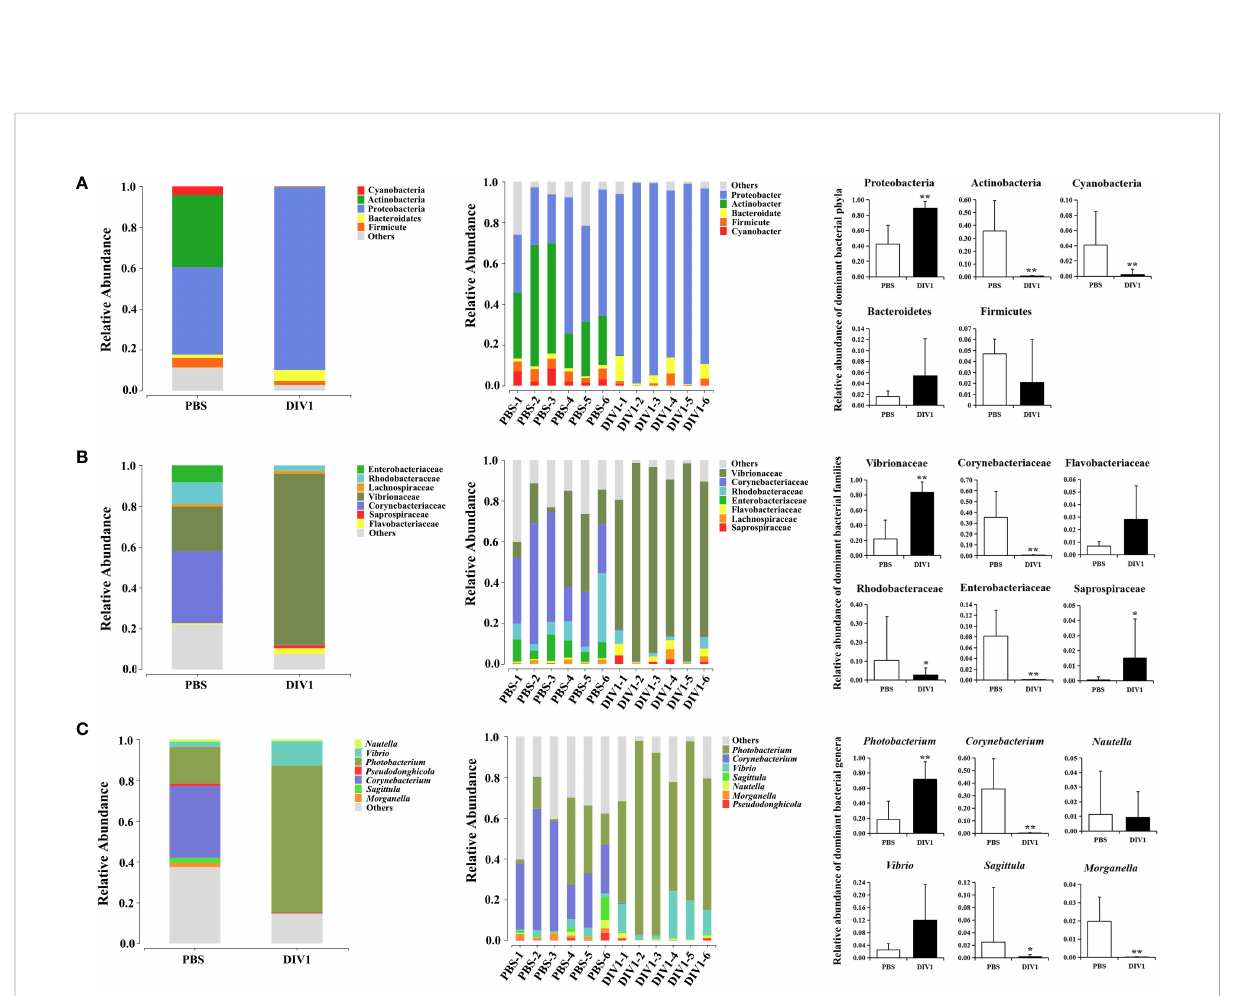
FIGURE 4 Structure and composition of the intestinal bacterial communities under DIV1 infection (mean ± SD). (A) Relative abundances of dominant bacterial phyla. (B) Relative abundances of dominant bacterial families. (C) Relative abundances of dominant bacterial genera.* Indicates a signi fi cant difference (*p < 0.05; **p <